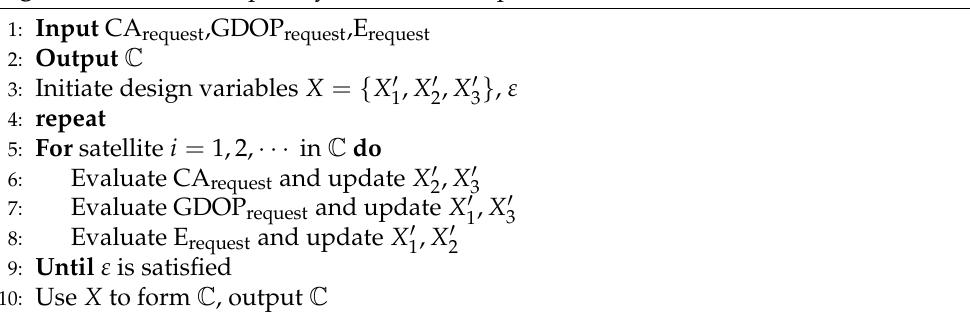
Algorithm 1 Multidisciplinary collaborative